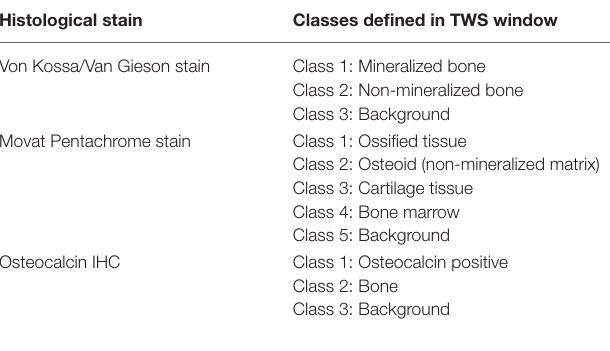
TABLE 2 | Values obtained from the TWS, BoneJ, and ImageJ toolbox protocols (in µ m). Histological